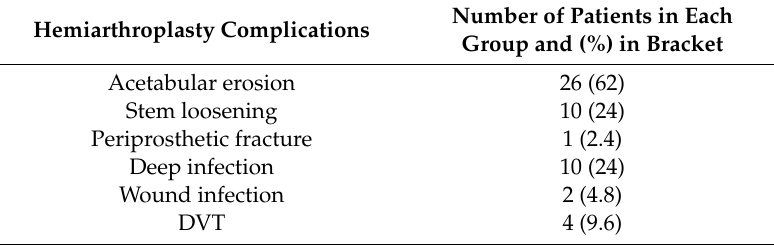
Table 4. Hemiarthroplasty complications.